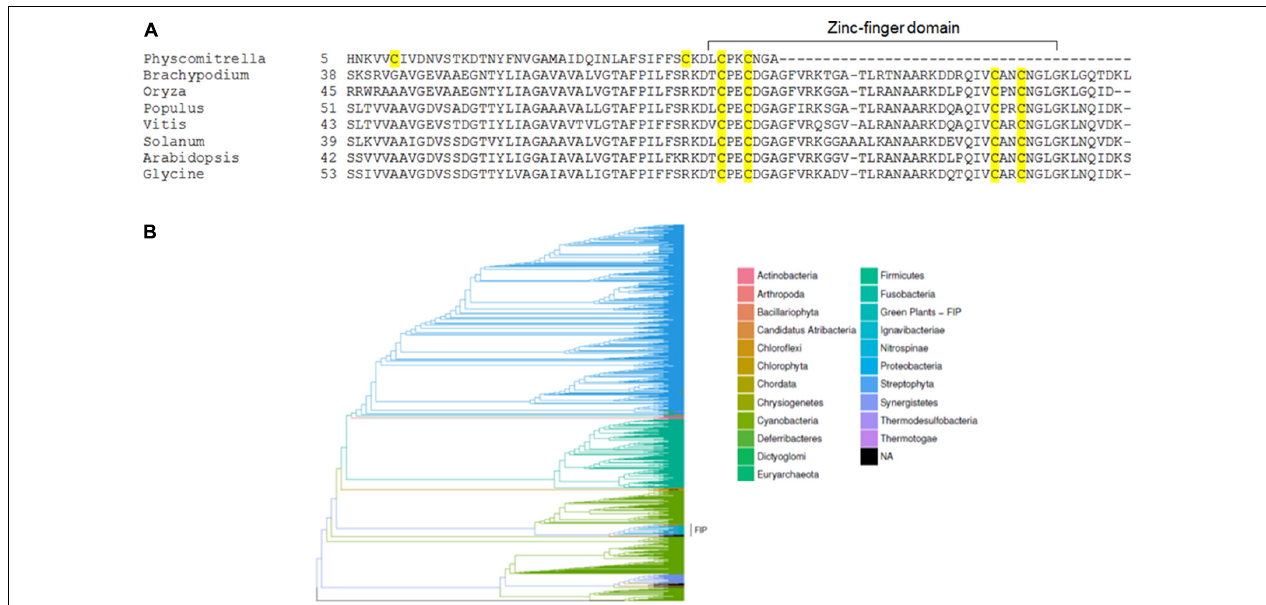
FIGURE 3 | FIP homologues are restricted to terrestrial plants. (A) Amino acid sequence alignment of several FIP homologues. Cysteine residues are highlighted in yellow, and the zinc-finger domain is marked. Physcomitrella was included in the alignment for comparison. (B) Bayesian phylogenetic inference of type A FtsH homologous sequences were identified using the amino acid sequences of FtsH1 (At1g50250) and FtsH5 (At5g42270) through the blastp algorithm against the refseq_protein GenBank database, including 2073 sequences that were above the threshold e -value of ≤ 1e-180. The results produced 1 × 10 6 MCMC (Markov chain Monte Carlo) generations sampled at each 1000 generations, yielding 1000 estimates. The cluster bearing sequences homologous to FIP was recovered as a monophyletic taxon and is highlighted.